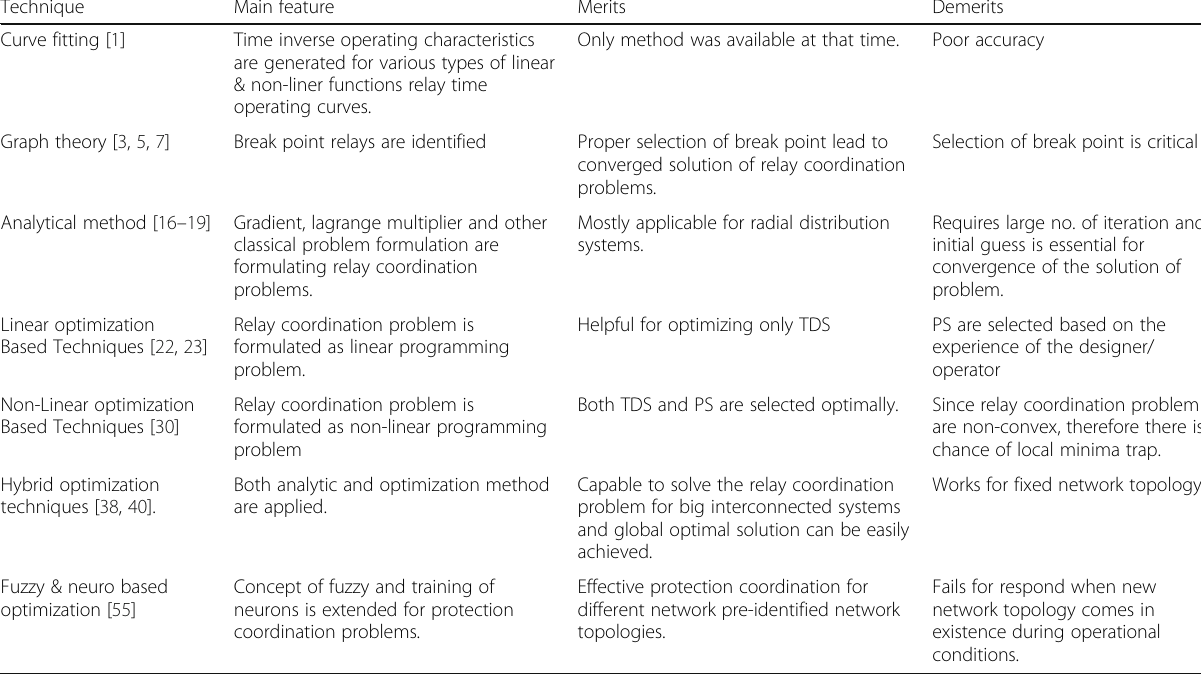
Table 1 Summary of different techniques used for protection coordination of distribution systems without DER penetration